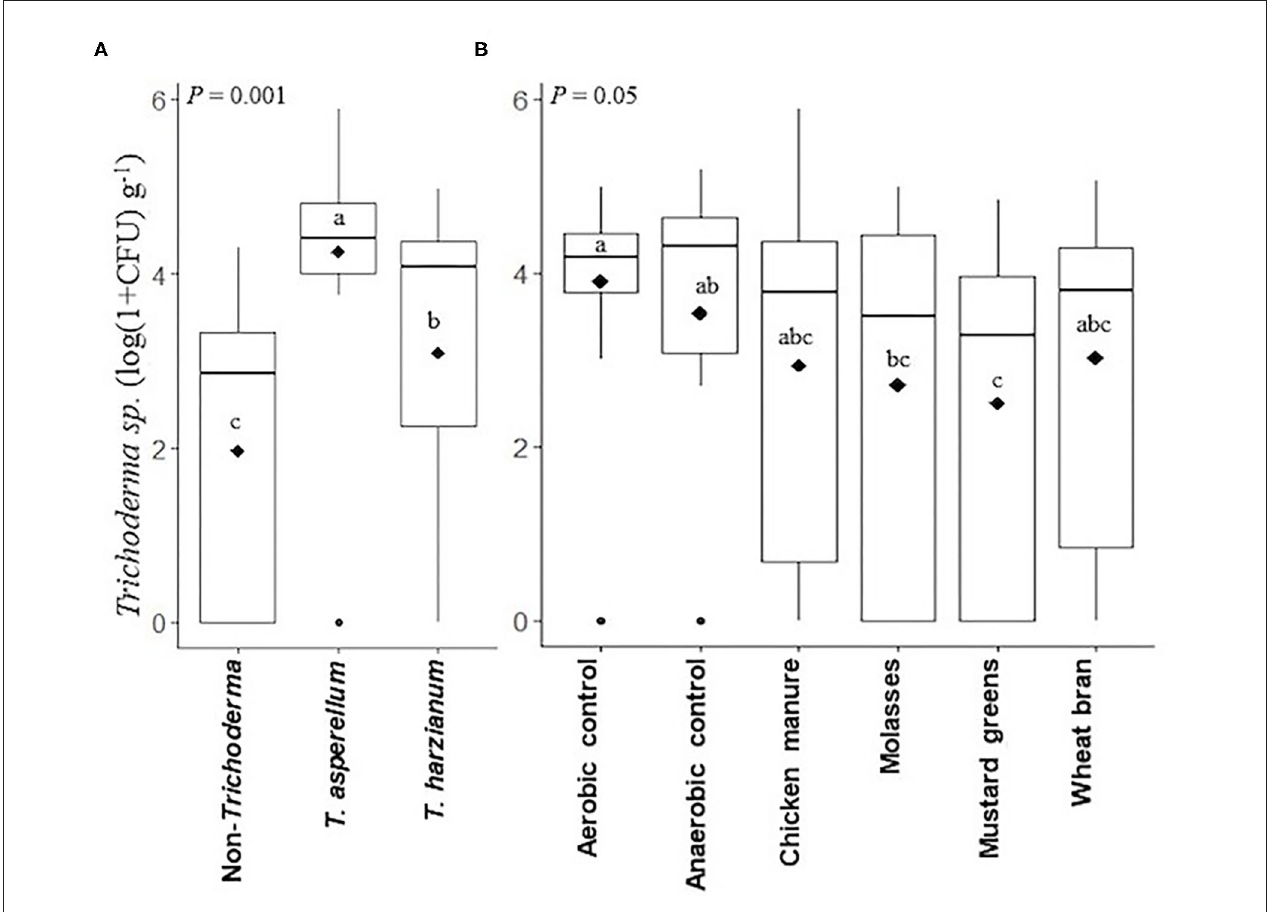
FIGURE 4 | Trichoderma populations (colony forming units g − 1 soil) after ASD treatment affected by Trichoderma isolate inoculation (main plot) (A) and anaerobic soil disinfestation (ASD) carbon source subplots (B) presented in box plots; black lines indicate median black diamonds indicate mean values and black dots are outliers, P -value is the analysis of variance probability value after 1 + log transformation, CFU indicates colony forming unit, means followed by same letter(s) do not differ significantly at 5% level of probability. Data presented are from two combined independent experiments each with three